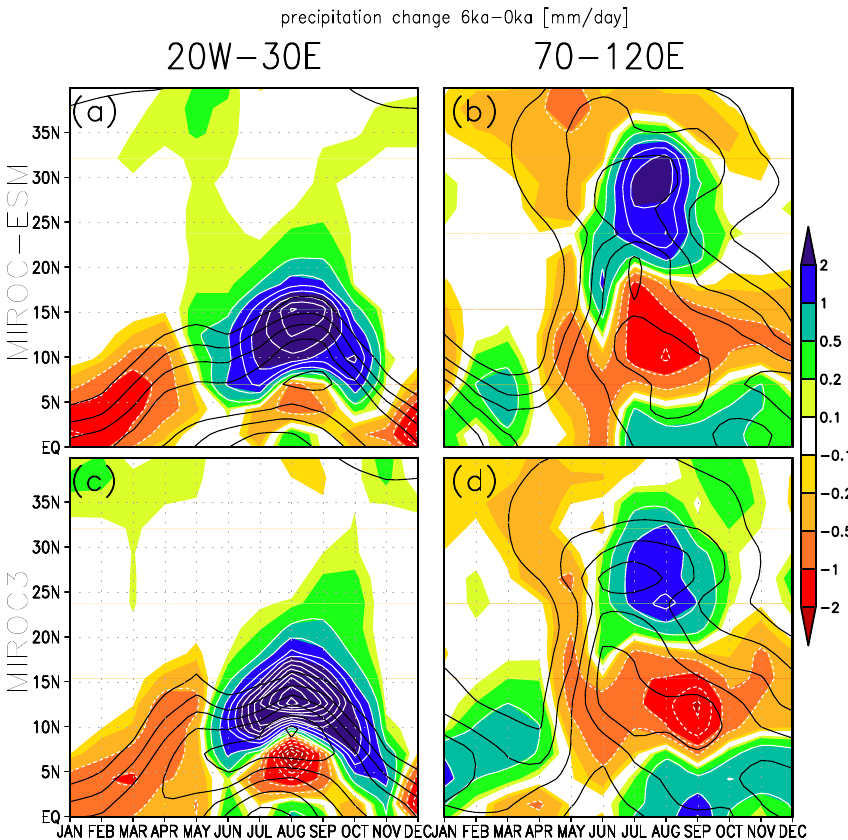
Fig. 13. Hovm¨oller diagrams for the northern African area (left panels) and Indian area (right panels) obtained with MIROC-ESM (upper panels) and MIROC3 (lower panels). Colors indicate the 6–0ka precipitation change (mmday − 1 ). Black lines denote the 0ka precipitation amount in intervals of 2mmday − 1